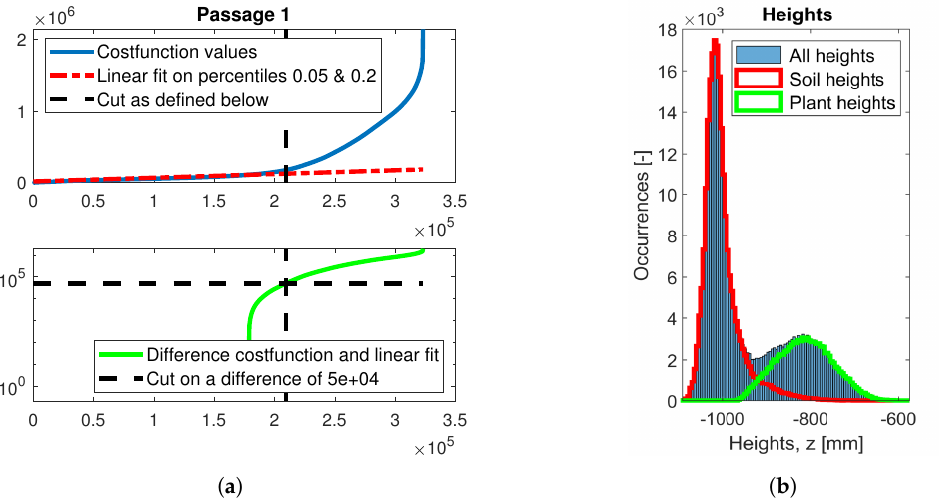
Figure 3. After calculating the weighted sum of each point in the strip, the cloud can be divided into plants and soil as summarized graphically in ( a ), to obtain the division shown in ( b